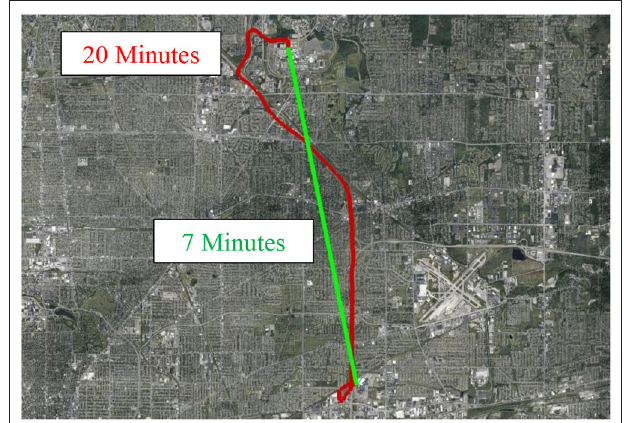
FIGURE 3 | Navigational benefits of flying